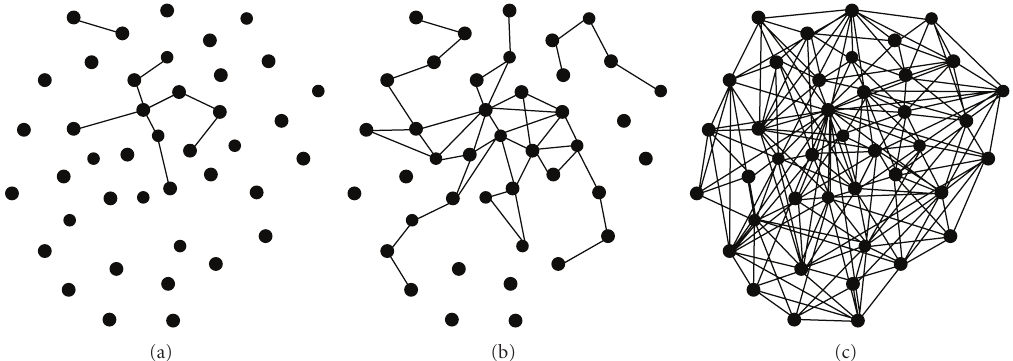
Figure 2: Gene networks for simulated gene data with di ff erent thresholds. (a) T 1 = 2 . 2; T 2 = 0 . 8; (b) T 1 = 2 . 0; T 2 = 1 . 0; (c) T 1 = 1 . 8; T 2 = 1 . 2.